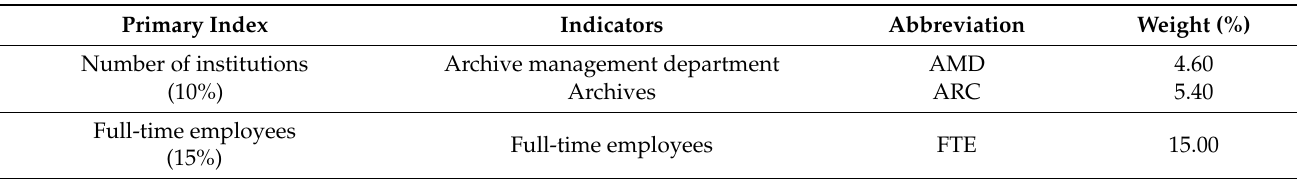
Table 1. Indicators to assess the development of Chinese archival